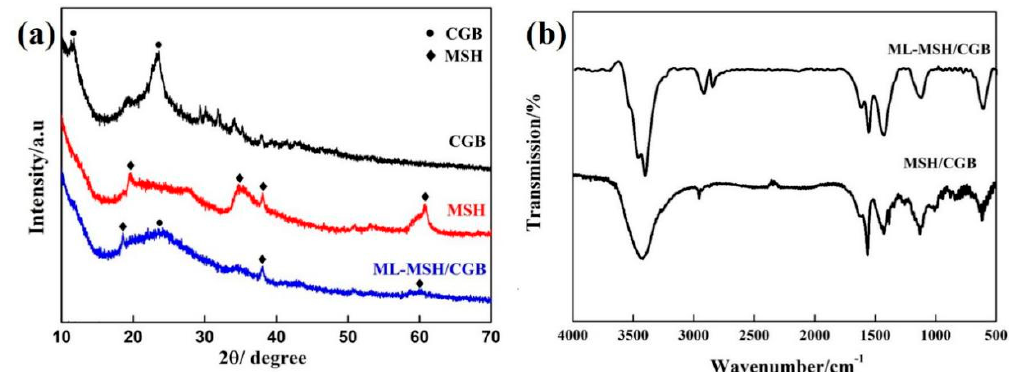
Figure 1. Typical low and high-magnification scanning electron microscopy (SEM) images of ( a ) nano-magnesium silicate hydroxide (MSH) particles, ( b ) crumpled graphene balls (CGB), ( c , d ) MSH/CGB composites.